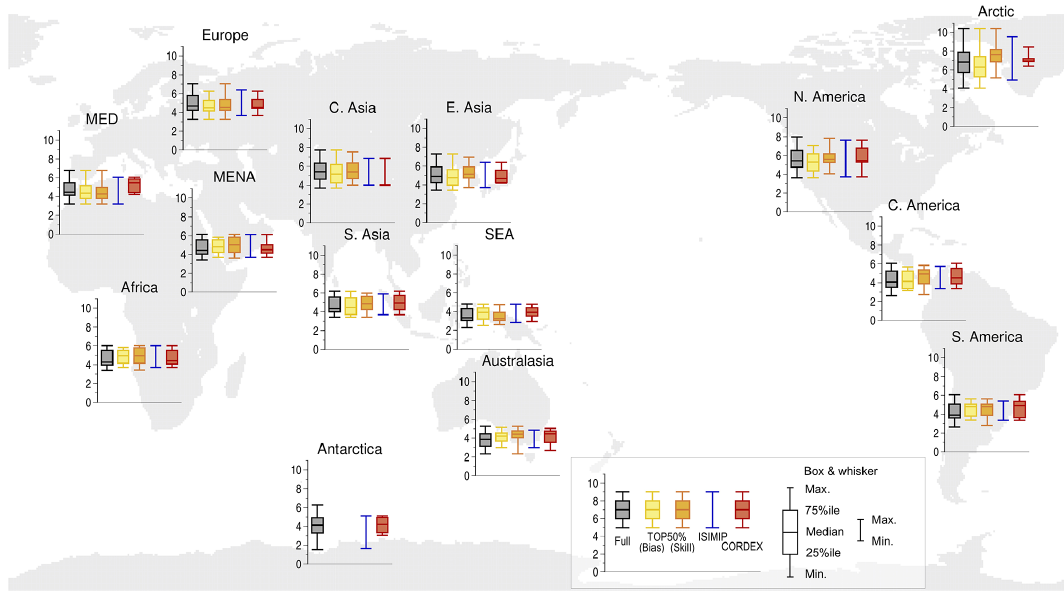
Figure 2. Annual mean temperature increments in the future climate projection (K). The whiskers of the box plots show the range between the maximum and the minimum increments. The boxes and the lines within the boxes show the 25th to 75th percentile range and the median respectively. Box plots indicate the increment in the full set of 42 CMIP5 models (black), the model sets with the top 50% of the CMIP5 models for the bias (yellow) or Taylor’s skill score (orange) and the model sets selected for ISIMIP (blue) and CORDEX (red). The top 50% of the CMIP5 models cannot be plotted over Antarctica because of the lack of CRU reference